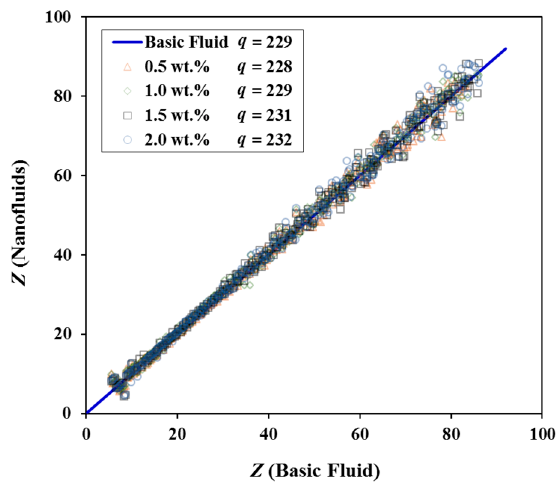
ff erent w values.